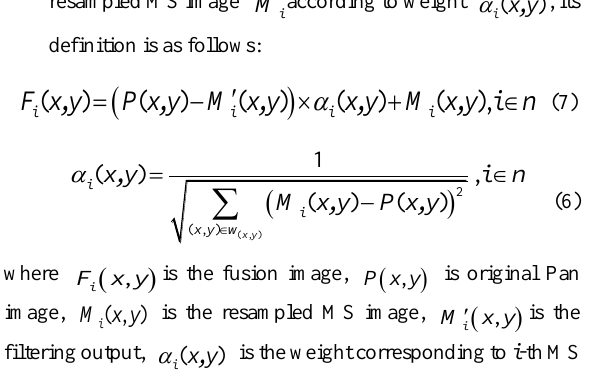
Table 1. Characteristics of the employed GF-2